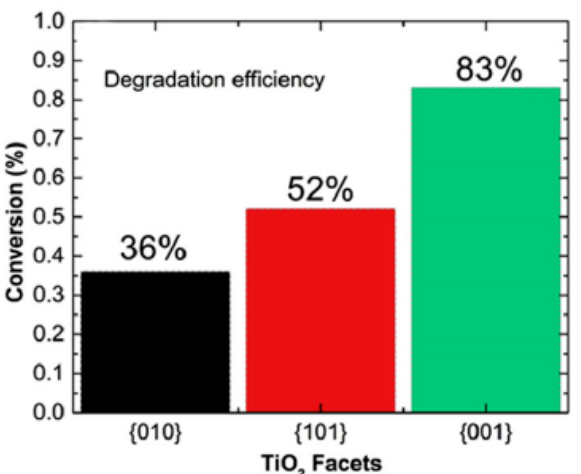
Figure 11. Degradation efficiency of gaseous acetaldehyde under UV/Vis irradiation in dependence on the dominant face of anatase type TiO 2 , the flow rate = 20 sccm (standard cubic centimeters). Reprinted from [59], Copyright 2020, with permission from Elsevier.